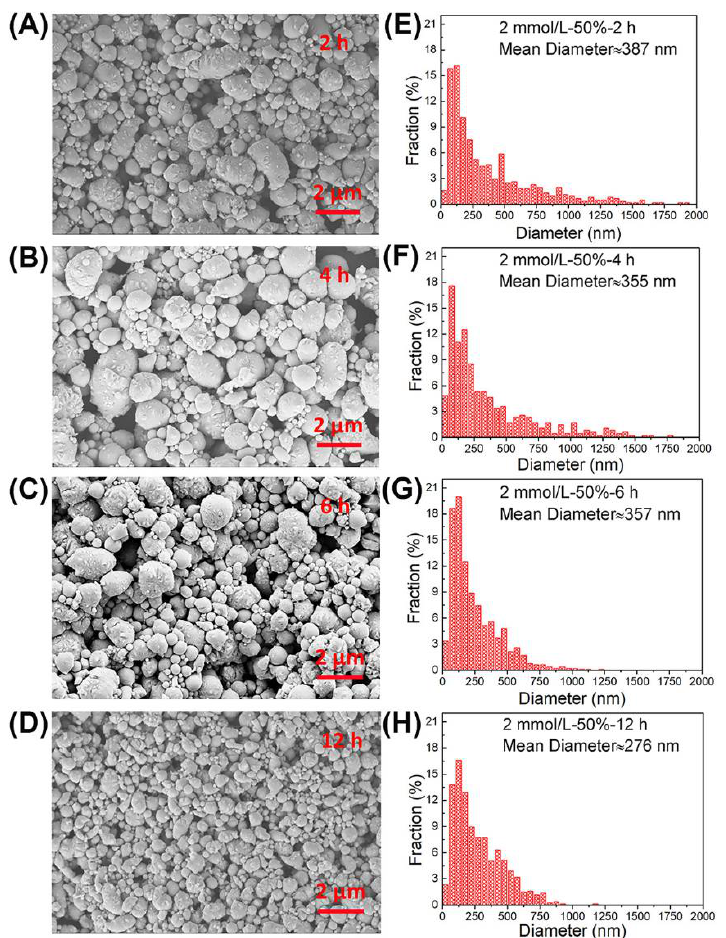
Figure 5. Morphology images and size distributions of eGaIn nanodroplets under different ultrasonic times: ( A , E ) 2 h ( B , F ) 4 h ( C , G ) 6 h and ( D , H ) 12 h. times: ( A , E ) 2 h ( B , F ) 4 h ( C , G ) 6 h and ( D , H ) 12